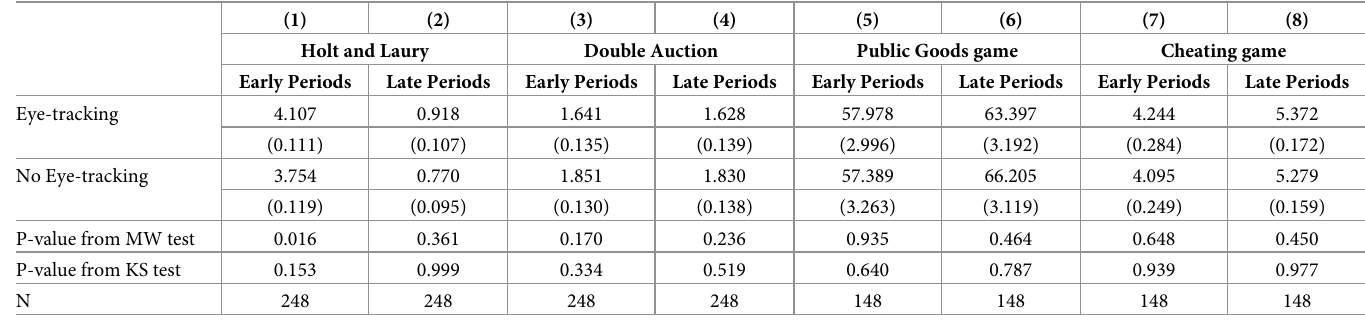
Table 4. Mann Whitney and Kolmogrov-Smirnov tests in early periods (1–5) and late periods (6–10) for the multiple periods